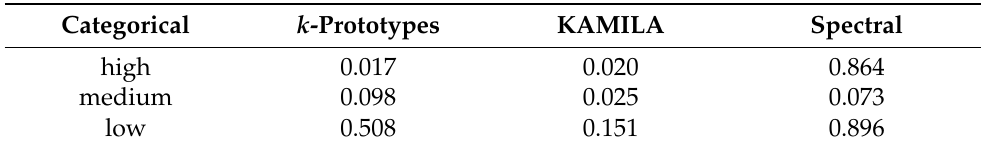
Table 5. Median ARI for different levels of overlap in categorical variables, n = 10 four-cluster data sets with non-convex clusters for continuous variables.